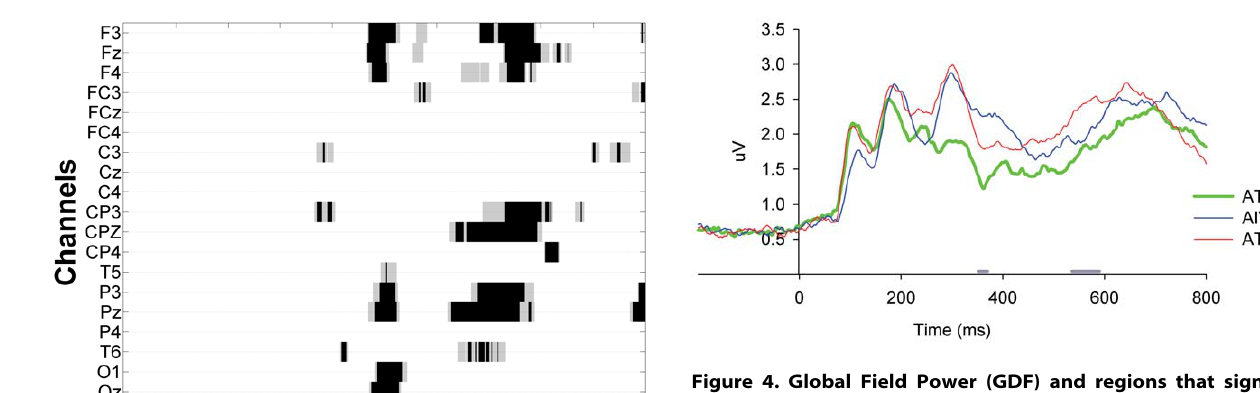
Figure 4. Global Field Power (GDF) and regions that signifi- cantly differ for dual targets. GDF measures for ATVI (auditory relevant target and visual irrelevant), AIVT (auditory irrelevant and visual relevant target) and ATVT (audiovisual dual relevant targets) stimuli. Gray bars depict time samples where ATVT significantly differ from both ATVI and AIVT for at least 12 consecutive samples (plot of Q-values from Tukey post-hocs comparisons following significant one-way